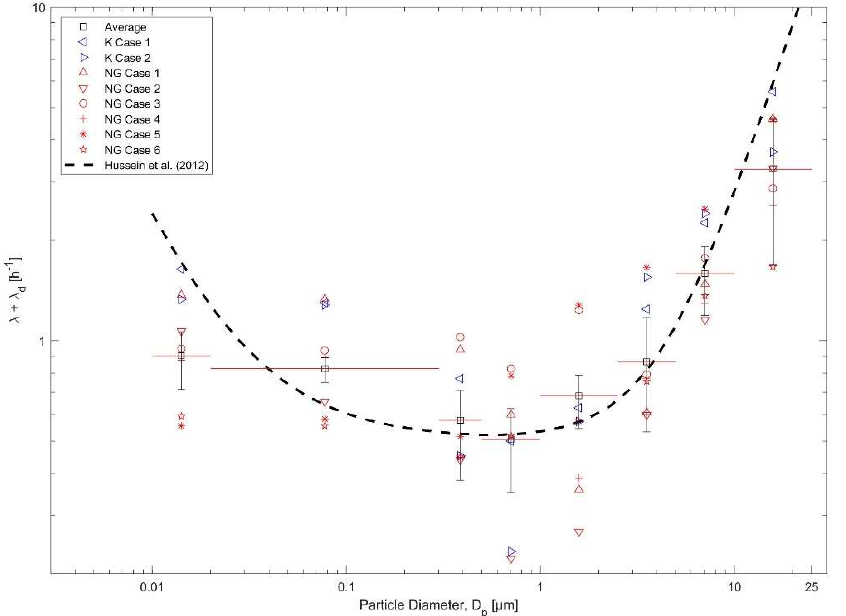
Figure 5. An average estimation for the total particle loss inside the test room compared with the three-layer model calculation (Hussein, et al. [59]).